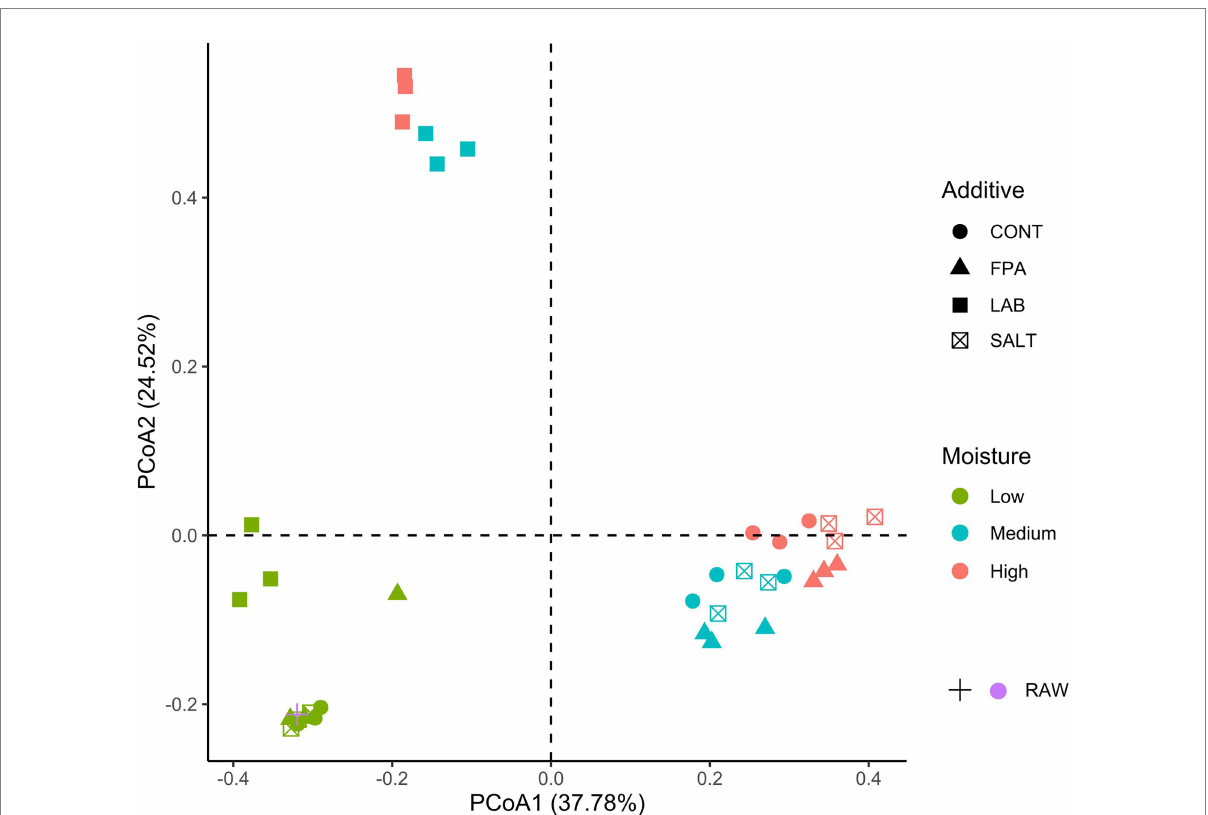
FIGURE 1 Principal coordinate analysis (PCoA) of the beta diversity analysis of crimped barley grain ensiled under different moisture content levels and treated with additives. CONT: control, FPA: formic and propionic acid-based additive, LAB: inoculation with homolactic and heterolactic acid bacteria strains, SALT: salt-based additive, Low: low moisture content, Medium: medium moisture content, High: high moisture content, RAW: raw material prior to